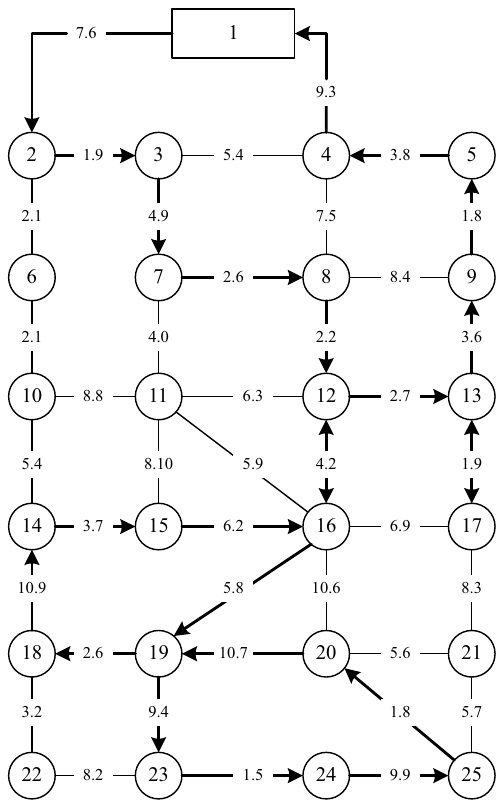
Fig. 2. The routing plan results of Jerby and Ceder (2006) Fig. 3. The routing plan results of Kuo and Luo (2011)